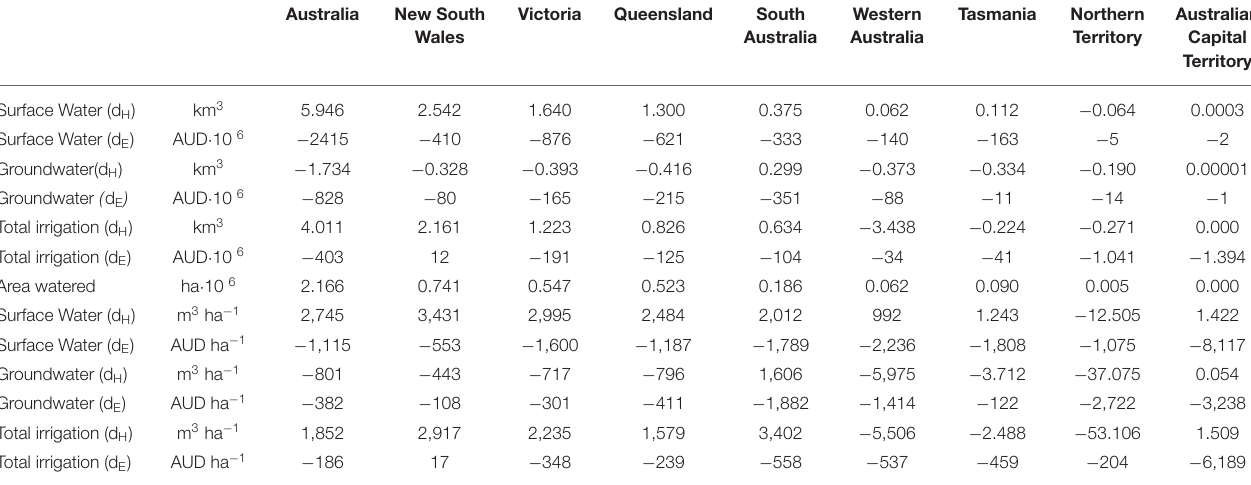
TABLE 6 | Average hydrological deficit ( d H ) and socio-economic deficit ( d E ) over the period 2002–2017 for 8 NRM regions.